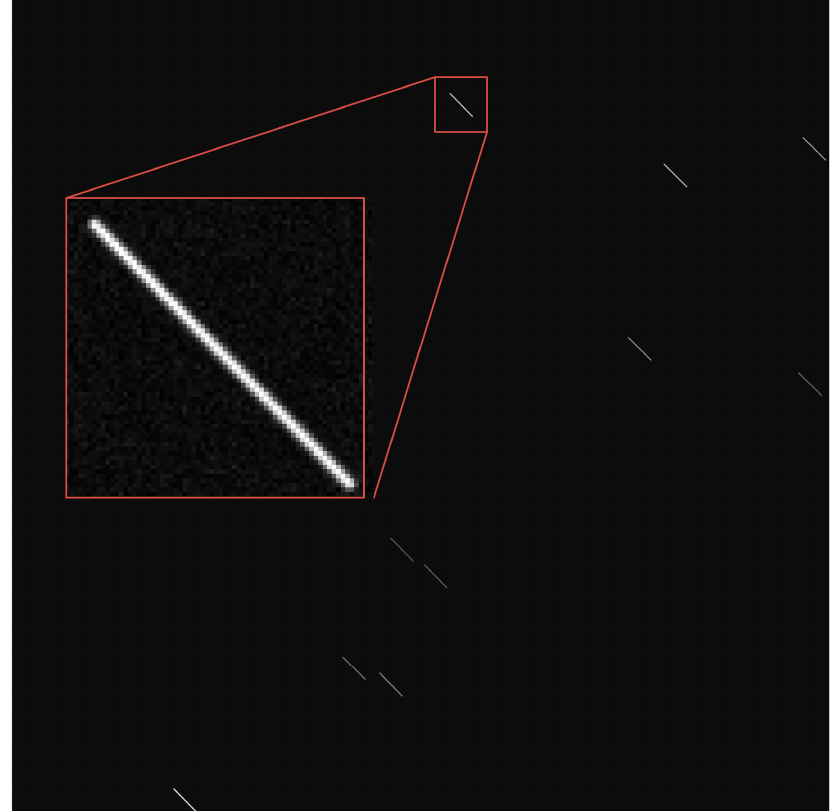
Figure 9. A dynamic smearing star image simulated in the staring–tracking imaging.